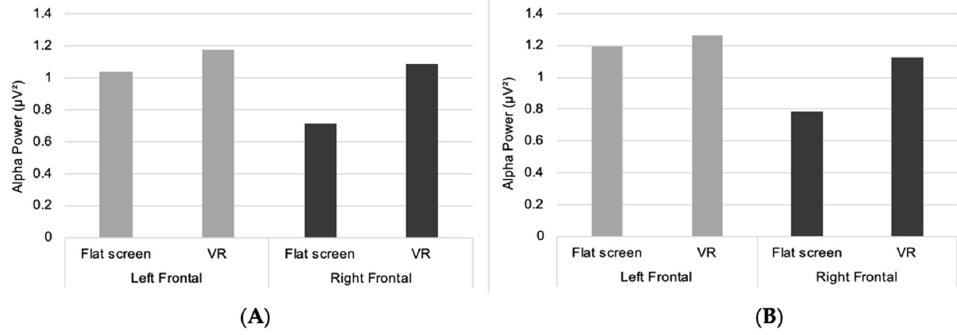
Figure 5. Hemispheric differences in frontal alpha power (µV ² ) for green ( A ) and blue ( B ) environ- ments.